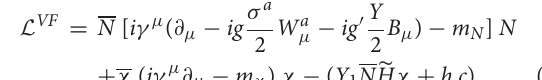
mixing angle (sin α ) should be kept small, as we have shown in Figure 13 . Therefore, the ILD becomes a viable DM candidate